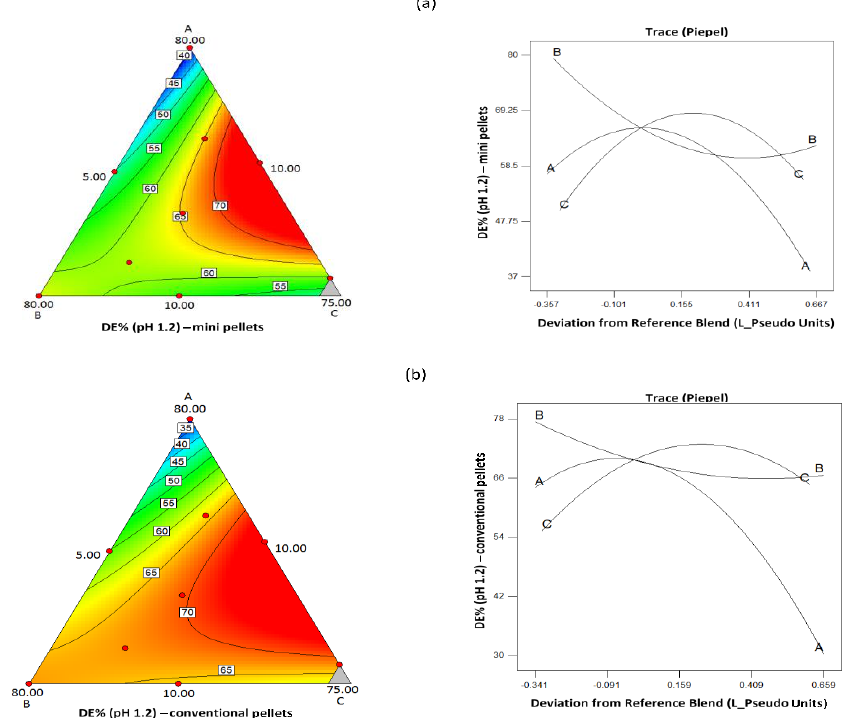
Figure 11. Contour and trace plots of dissolution efficiency for ( a ) mini and ( b ) conventional pellets at pH 1.2.